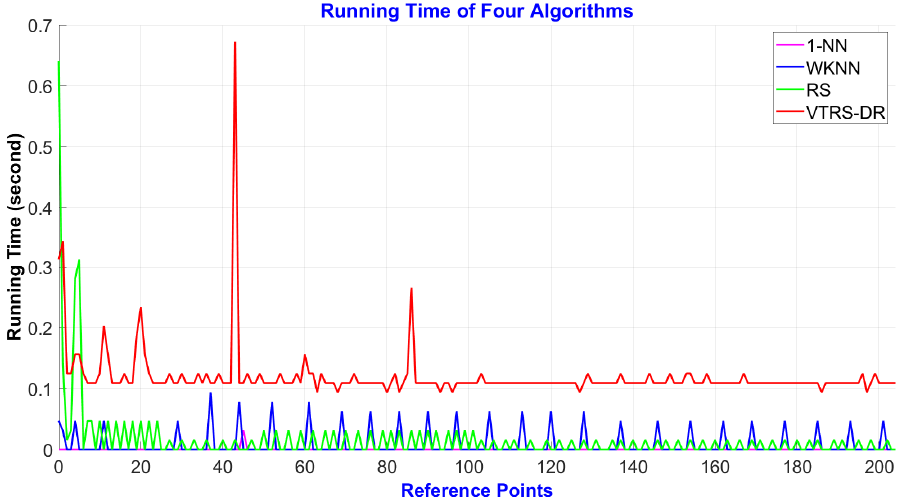
Figure 7. The running time of four methods via 205 RPs in Case 1.